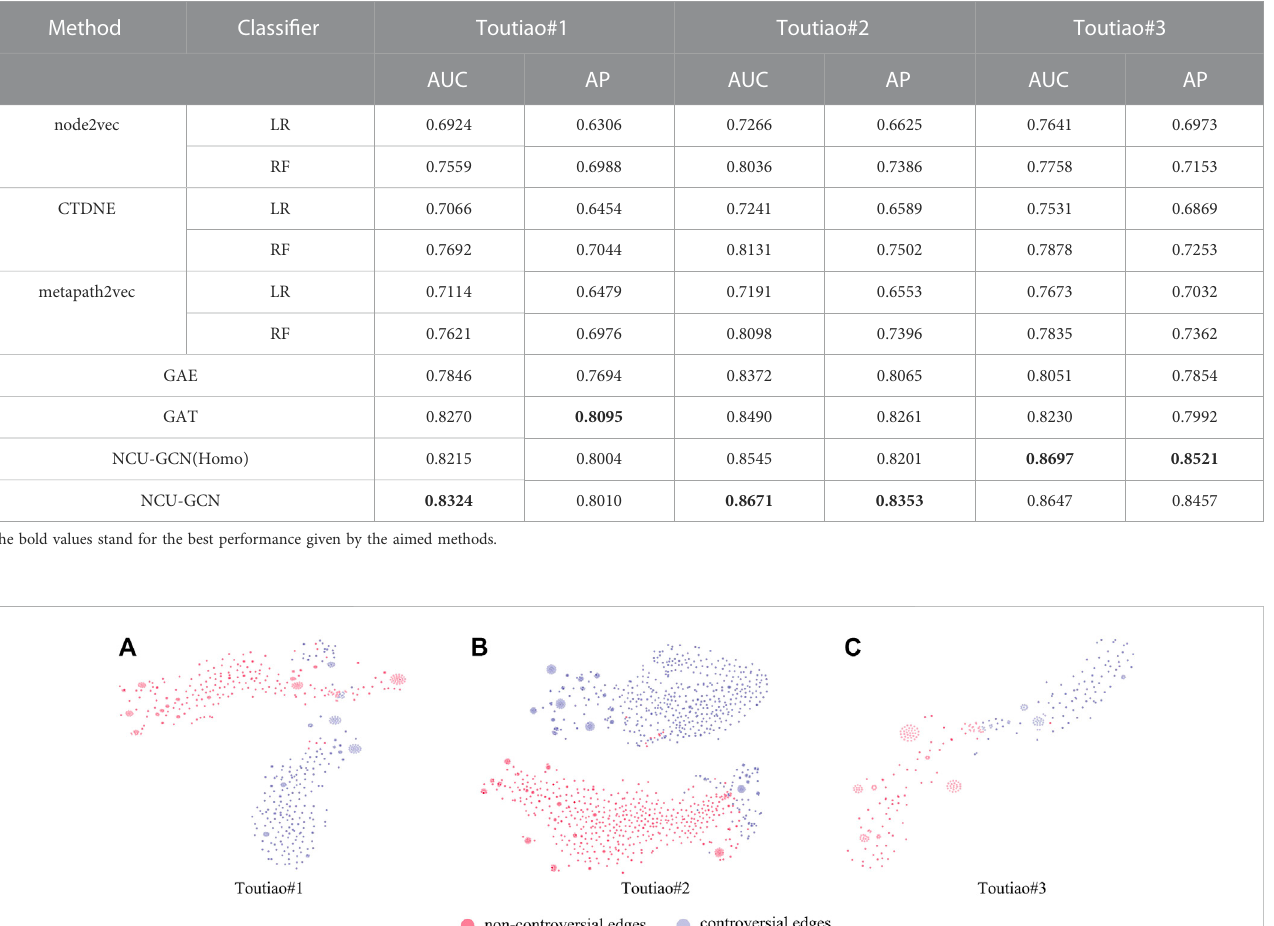
TABLE 3 Performance of different methods among three subsets with respect to AUC and AP.